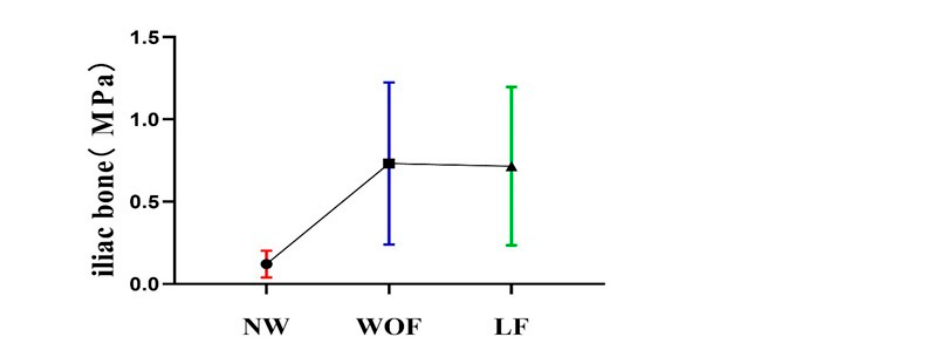
Figure 5. Iliac bone stress distribution cloud map. NW, normal walking; WOF, warding off with steps forward; LF, laying with steps forward. Equivalent stress distribution of the iliac bone during two progressive motions of Bafa Wubu and NW is shown. The warmer the color, the greater the stress. The red arrow indicates the maximum stress, and black lines around bones indicate their displacement distance.